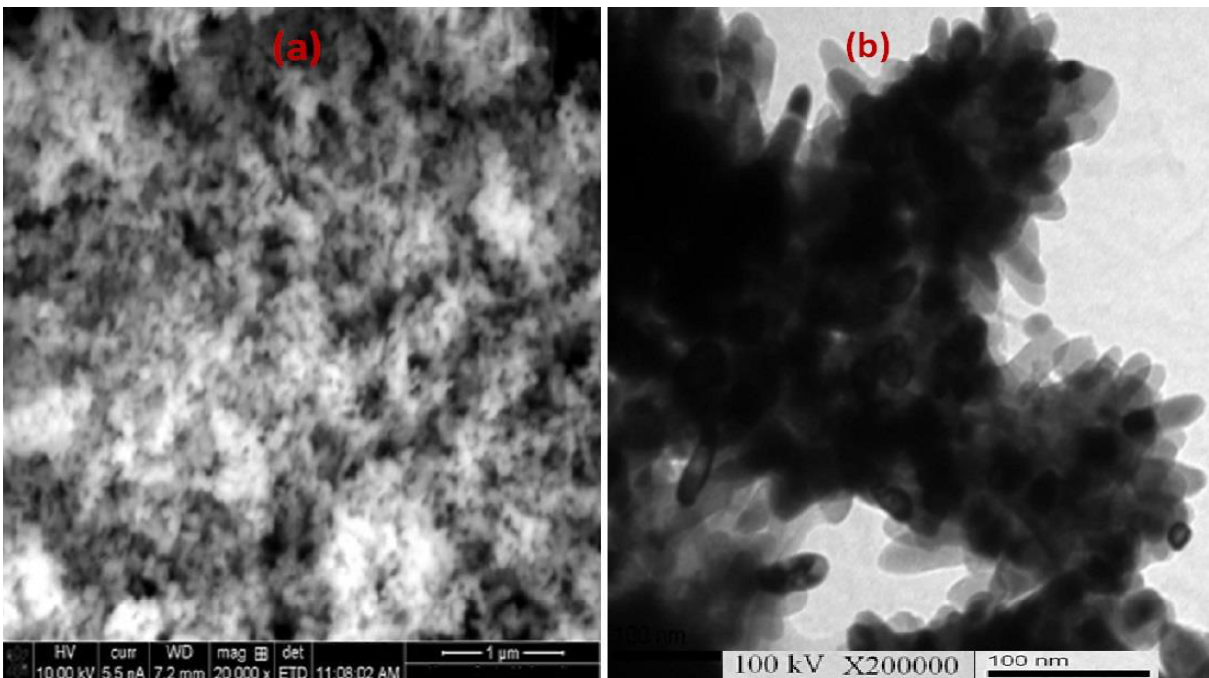
Figure 3. ( a ) SEM and ( b ) TEM micrographs of Co 3 O 4 nanorods.